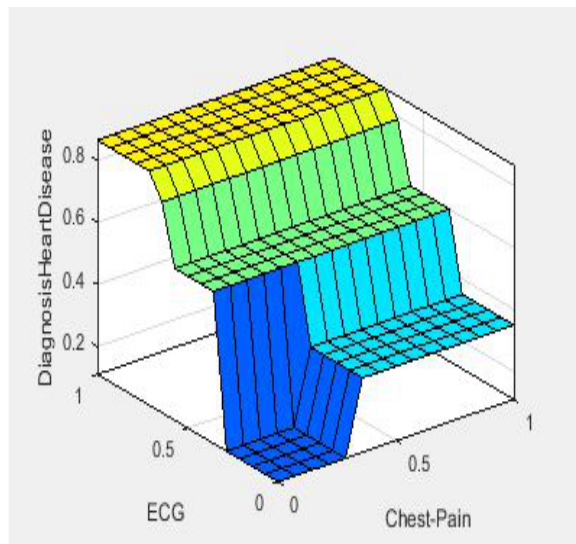
Fig. 4. Proposed DHD-MFI expert system Rule surface of w.r.t. Chest Pain & ECG.